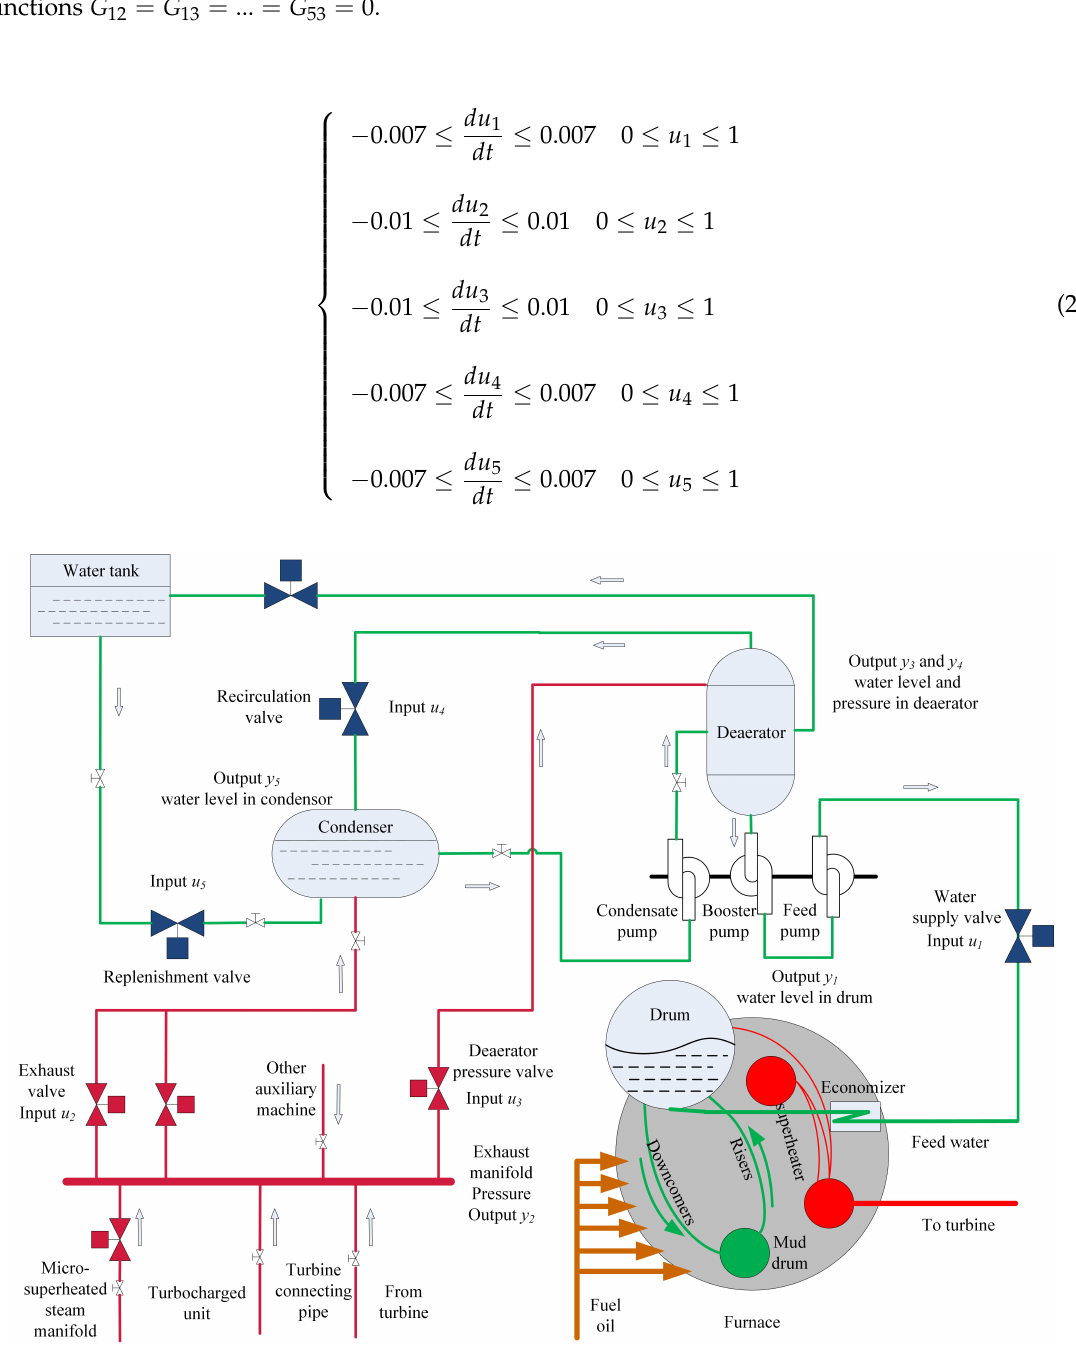
Figure 1. Scheme of steam/water loop [38] (reproduced with permission from Zhao, S.; Maxim, A.; Liu, S.; De Keyser, R.; and Ionescu, C, Processes; published by MDPI,